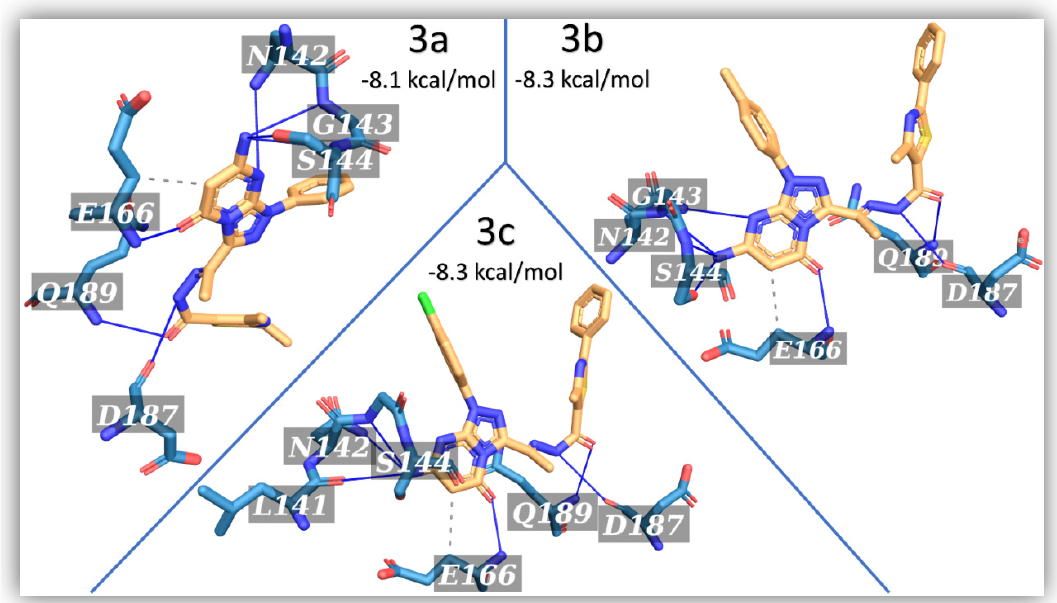
Figure 3. The interaction pattern (after docking) for the best three thiazole compounds, 3a , 3b , and 3c , depicted using PyMOL software. The compounds are shown in yellow sticks, while the interacting residues form SARS-CoV-2 M pro are depicted in blue sticks labeled with its one-letter codes. The formed H-bonds and hydrophobic contacts are shown in blue and dashed-gray lines, respectively.